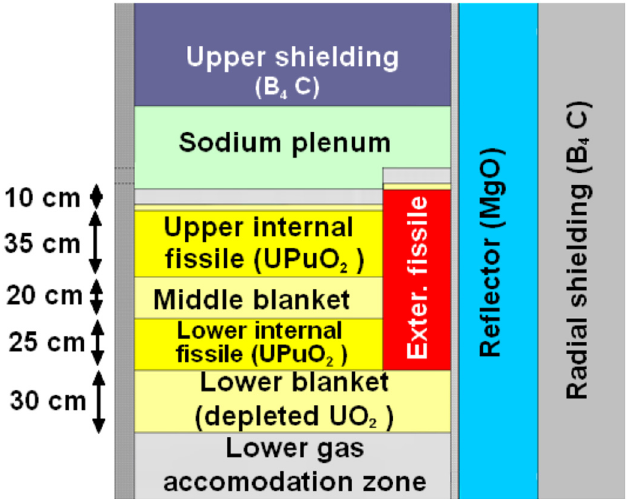
Fig. 1. Axial description of the